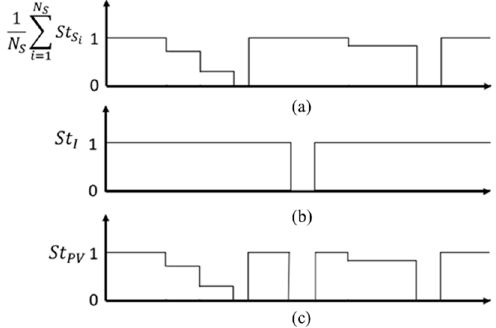
Figure 4. Chronological State Model of PV system.